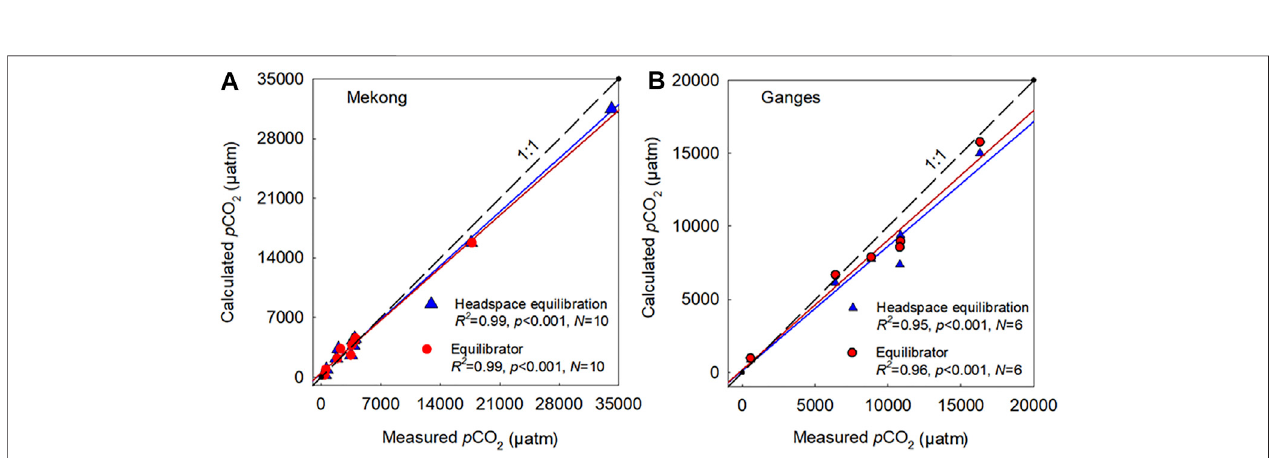
FIGURE 8 | Comparison of the calculated (CO2SYS) and measured partial pressure of CO 2 ( p CO 2 ) using manual headspace equilibration and spray-type equilibratoralongtheMekong (A) andtheGanges (B) .ManualmeasurementswereobtainedduringacruiseexpeditioninFebruary2018from6samplinglocationsalong the mainstems and tributaries of the Lower Ganges near Dhaka, Bangladesh and during a cruise expedition in January 2017 from 10 sampling sites along the Mekong- Tonle Sap and urban tributaries around Phnom Penh, Cambodia.